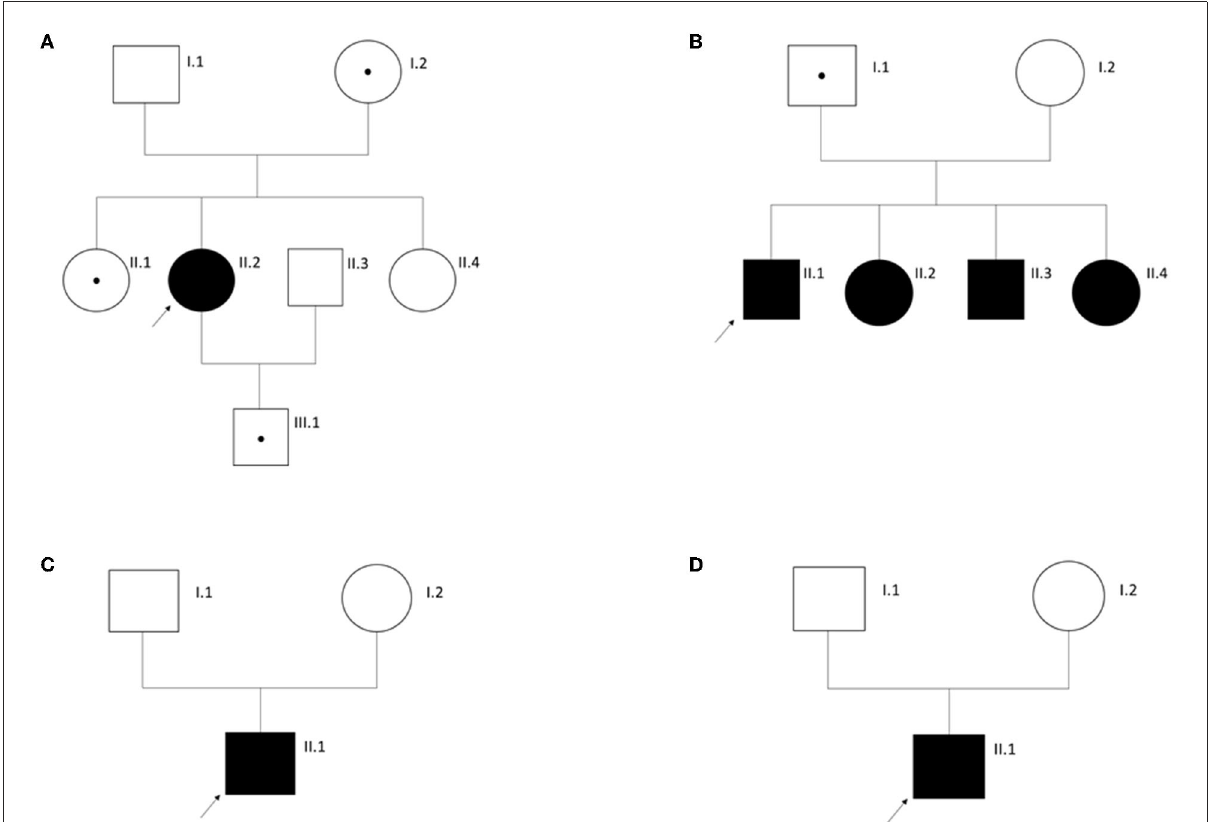
FIGURE2 Pedigrees of families with Alport syndrome as clinical tentative diagnosis in the index individual (arrow) and only a monoallelic disease-causing variant in COL4A3 . See Results for more information. (A) Family ATS-F521; (B) Family ATS-F663; (C) Family ATS-F787; (D) Family ATS-F788. Circles, females. Squares, males. A dot within a symbol signifies an unaffected carrier of the respective disease-causing variant.